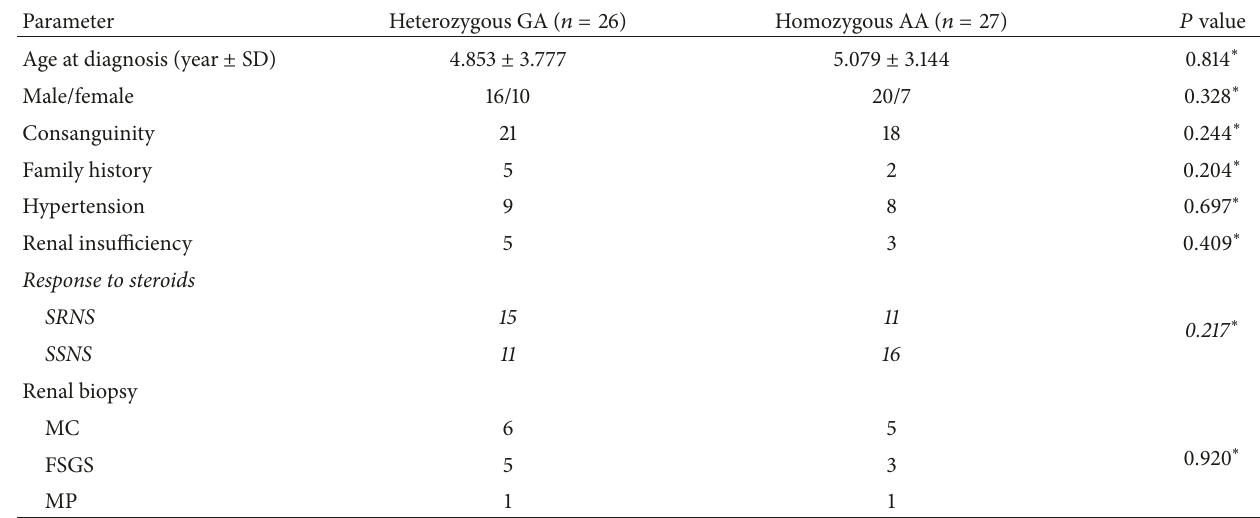
Table 5: The clinical data and disease progression of 53 children with heterozygous and homozygous polymorphic R229Q.